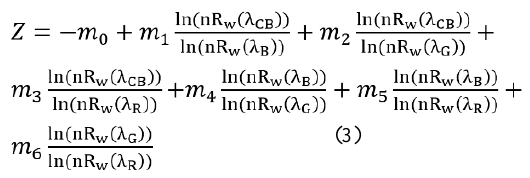
Figure 2. The hydrographic sounding points measured by single beam echo-sounder. The distance of sounding points is less in the regions with coarse topography and more in areas with smoother topography